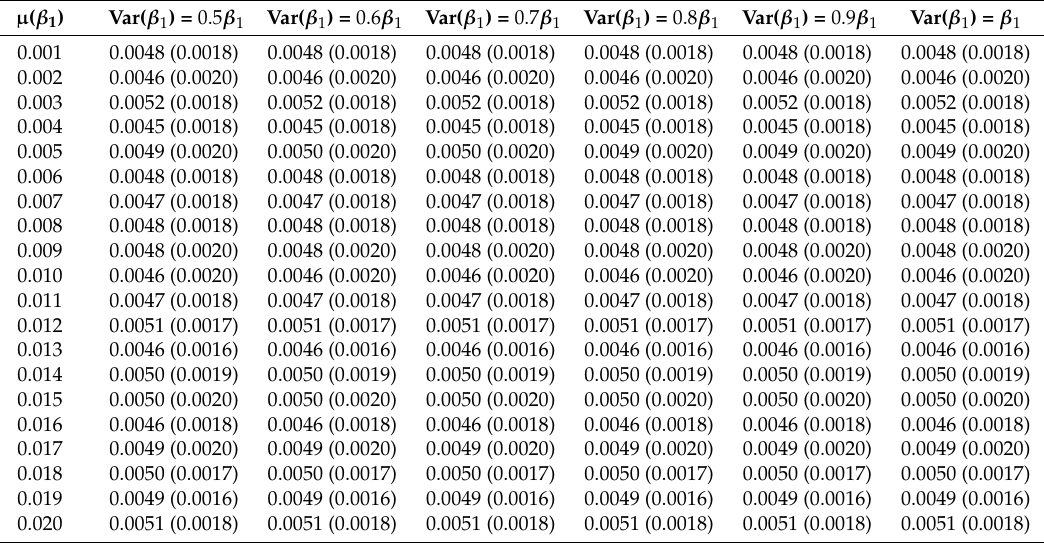
Table 5. Mean (SD) of estimated (cid:98) β 1 s derived from Bayesian GAMs with different priors. µ ( β 1 )